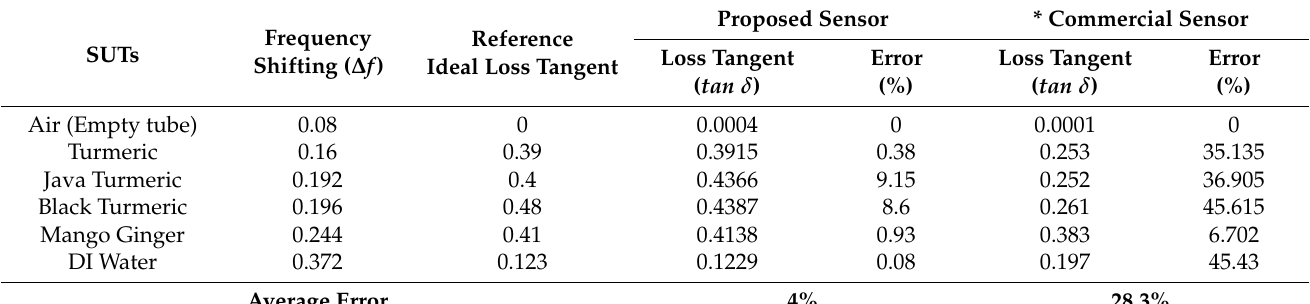
Table 8. Comparison percentage error of loss tangent between proposed and commercial sensor of SUT (semi-solid).